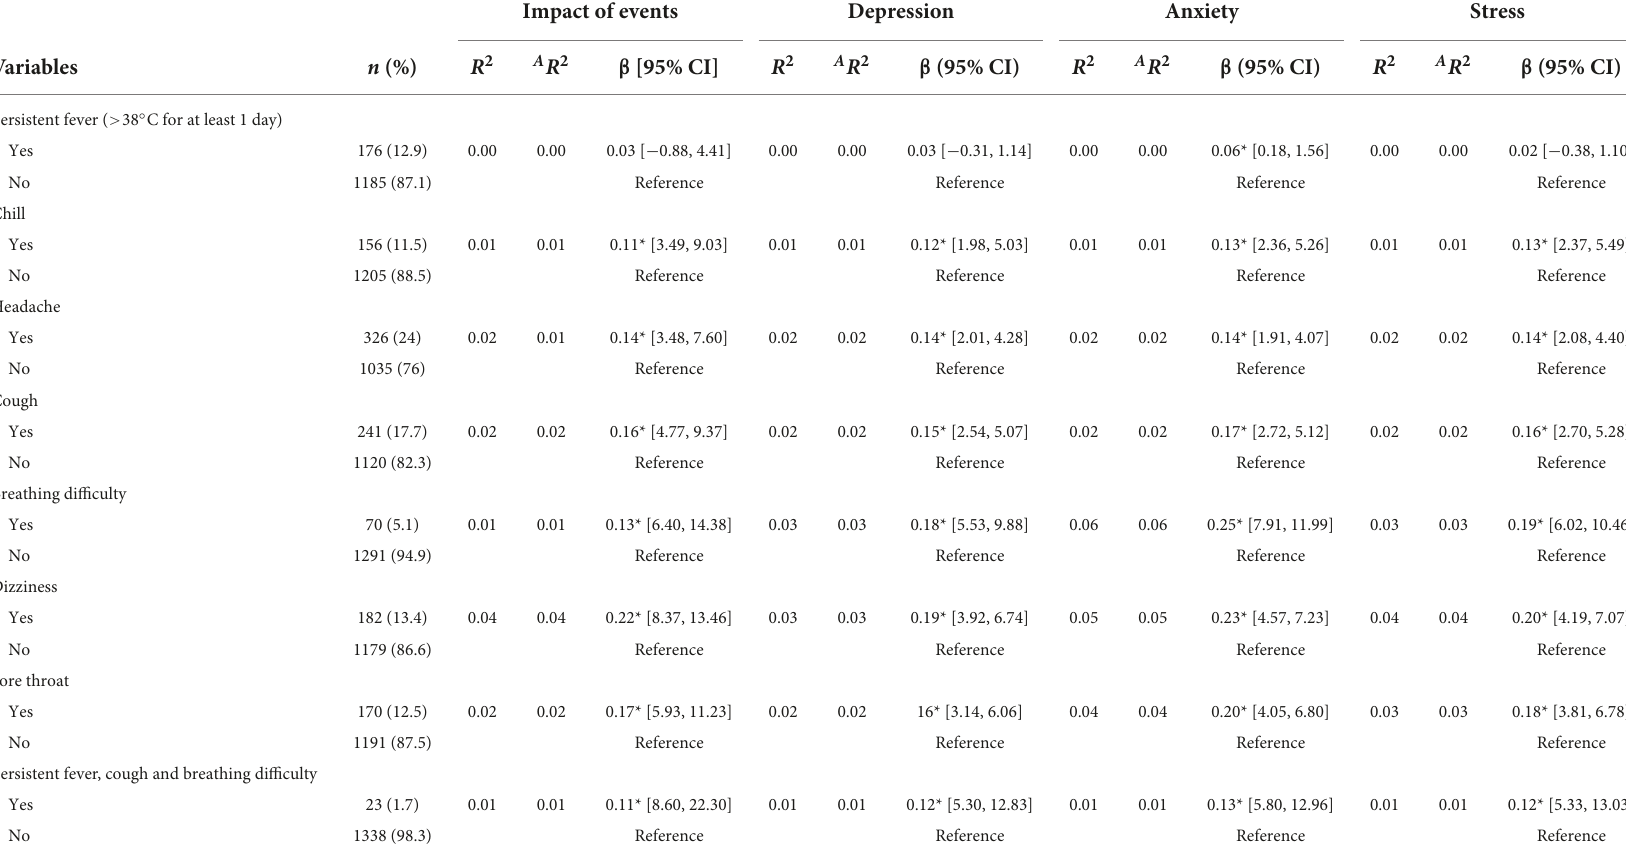
TABLE 4 Regression of associations between self-reported physical health status and scores on Impact of Events Scale-Revised and the DASS-21 Depression, Anxiety and Stress Subscales ( N = 1361). Impact of events Depression Anxiety